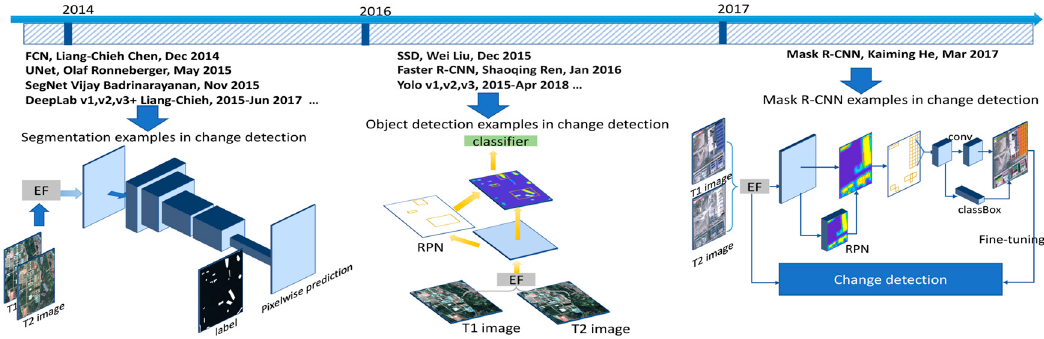
Figure 16. A development timeline of CNN application for change detection.